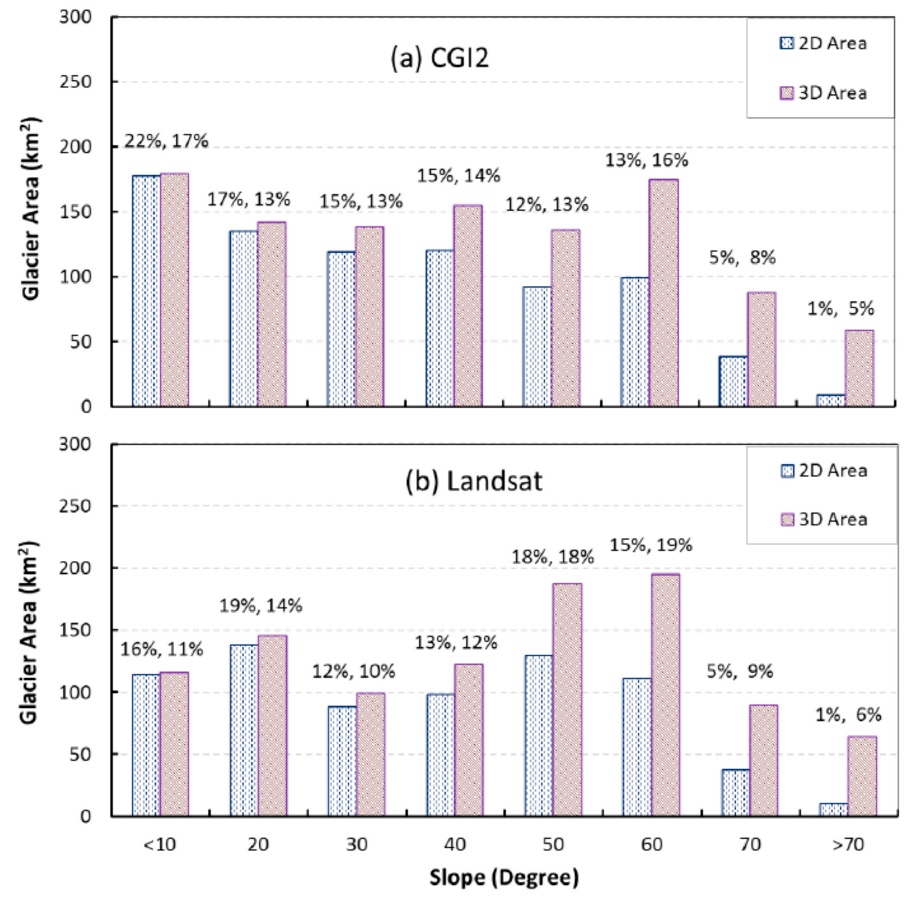
Figure 6. Histogram of glacier 2D and 3D areas within different slope zones based on the second Chinese Glacier Inventory (CGI2) data ( a ) and glaciers classified from Landsat images ( b ) on 24 August 2007 in the Muzart Glacier catchment. The numbers above the columns are the frequency percentages of glacier areas in each slope zones against total 2D and 3D areas, respectively.